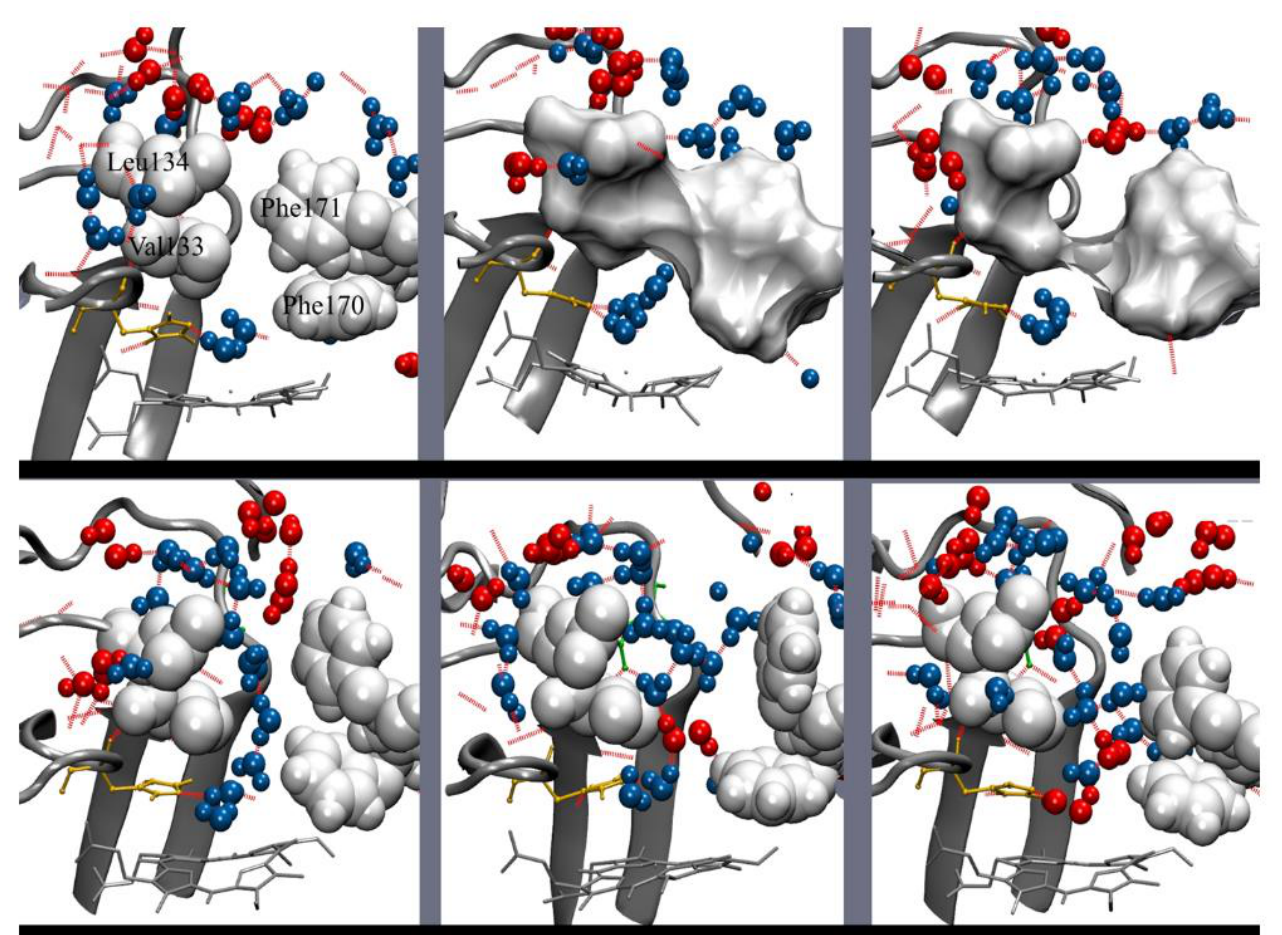
Figure 9. A gate valve mechanism at the FS in the main channel of CAT-1. Representation of the gate valve mechanism of CAT-1 during FS closing and opening obtained from a MD simulation. Upper panels: Phe171 rotates toward Leu134 and Phe170 toward Val133, closing the FS of the main channel, and draining solvent molecules from the FS. Water molecules (blue) are bound to the His92. Lower panels: Phe171 and Phe170 rotate away from Leu134 and Val133, respectively, allowing solvent molecules to enter the active site. The water molecule bound to His92 is displaced by H 2 O 2 (red).